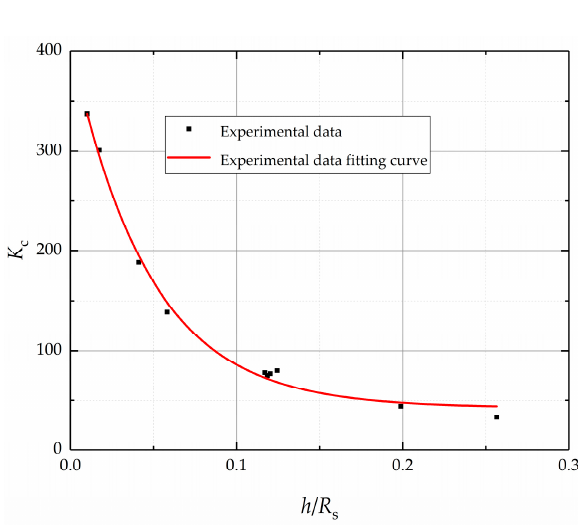
Figure 3. The critical coefficient